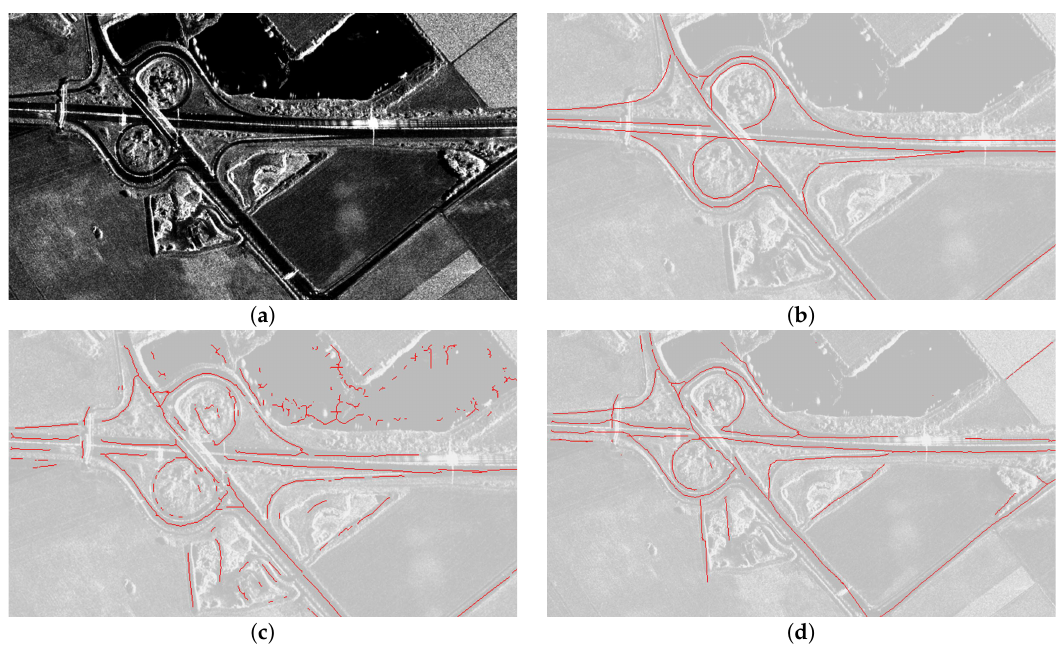
Figure 9. The effect of unary potential and pairwise potential in the proposed method. ( a ) TerraSAR image; ( b ) ground truth; ( c ) result of unary potential alone; ( d ) fusion result of CRF. Table 1. Comparisons of evaluation indices and time